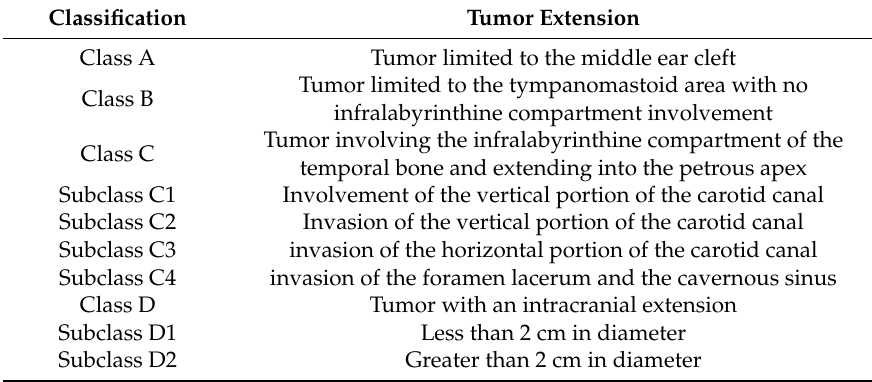
Table 1. Adapted Fisch classification of jugulotympanic paraganglioma